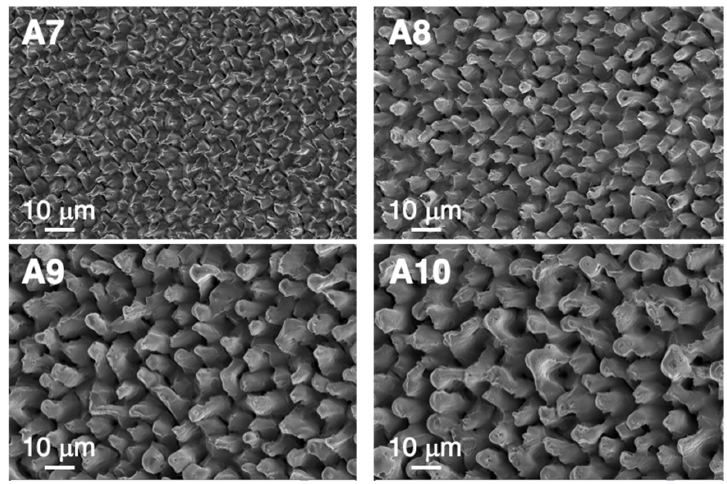
Figure 8. Top-view SEM (SE) images of the laser-processed microstructures generated an the Ni5W tape surface by using high F av and < F 1D > values, as explained in the text and in Table 2.